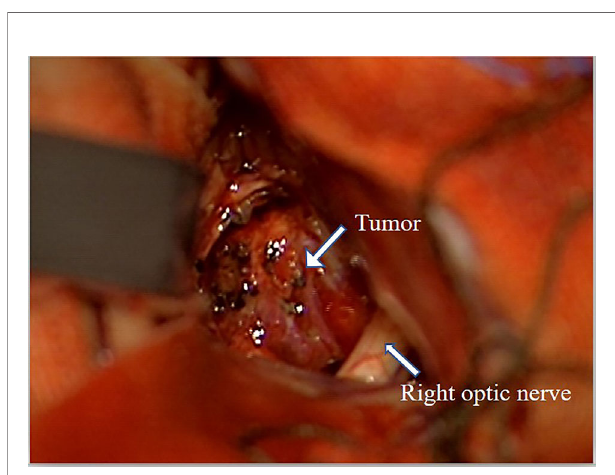
FIGURE 3 | Surgical pictures. Severe adhesion of the tumor and left optic